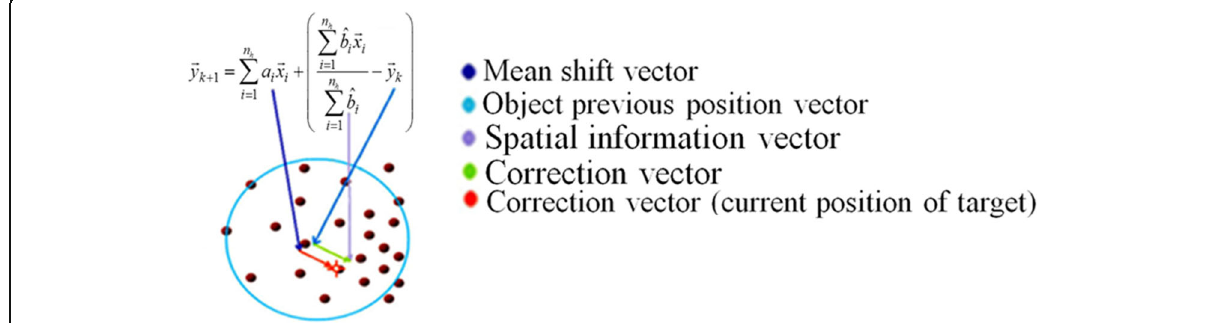
Fig. 13 Operation of proposed algorithm in finding denser points in the condition that mean-shift algorithm has lost target